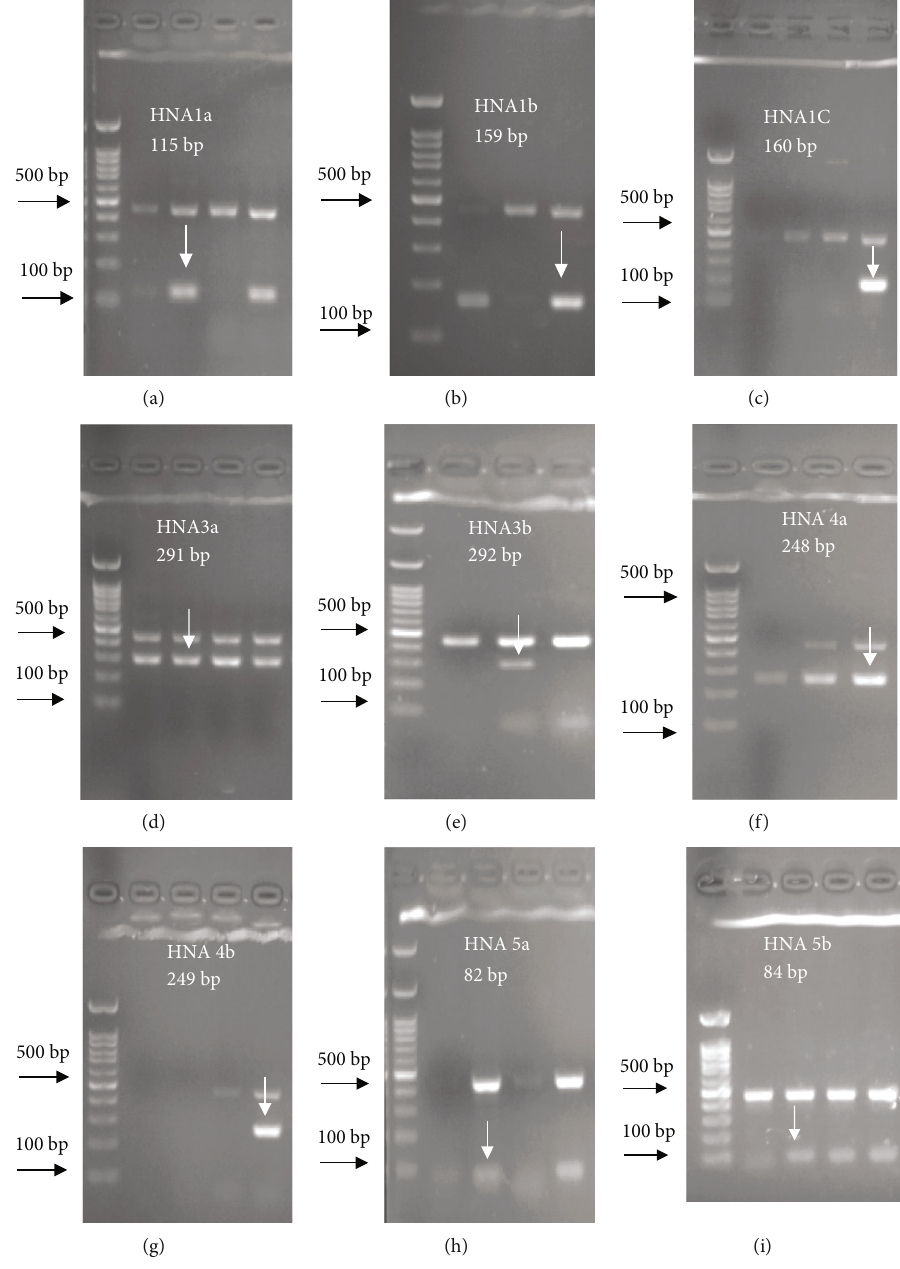
Figure 1: HNA allele-speci fi c amplicons separated by agarose gel electrophoresis. Gel electrophoresis images are related to FCGR3B ( FCGR3B ∗ 01 , FCGR3B ∗ 02 , FCGR3B ∗ 03 ), SLC44A2 , ITGAM , and ITGAL alleles on 1.5% agarose. The presence of each allele in the DNA samples was con fi rmed by the ampli fi cation of the related gene fragments using speci fi c primers by polymerase chain reaction sequence-speci fi c primer (PCR-SSP). (a – c) Individuals with FCGR3B ∗ 01 ( encoding HNA-1a), FCGR3B ∗ 02 ( encoding HNA-1b), and FCGR3B ∗ 03 ( encoding HNA-1c) positive alleles, respectively. (d, e) Individuals with positive SLC44A2 ∗ 1 (encoding HNA-3a) or SLC44A2 ∗ 2 (encoding HNA-3b) alleles, respectively. (f, g) Individuals with positive ITGAM ∗ 1 (encoding HNA-4a) or ITGAM ∗ 2 (encoding HNA-4b) alleles, respectively. (h, i) Individuals with positive ITGAL ∗ 1 (encoding HNA-5a) or ITGAL ∗ 2 (encoding HNA-5b) alleles, respectively. Sequence-speci fi c products are shown by arrows. Human growth hormone (HGH) (495bp) was used as an internal positive control for all PCR-SSP analyses. A DNA ladder (100 – 1000bp) has been run in the fi rst lane of the gels (on the left side) (Biofact, SM342-500,